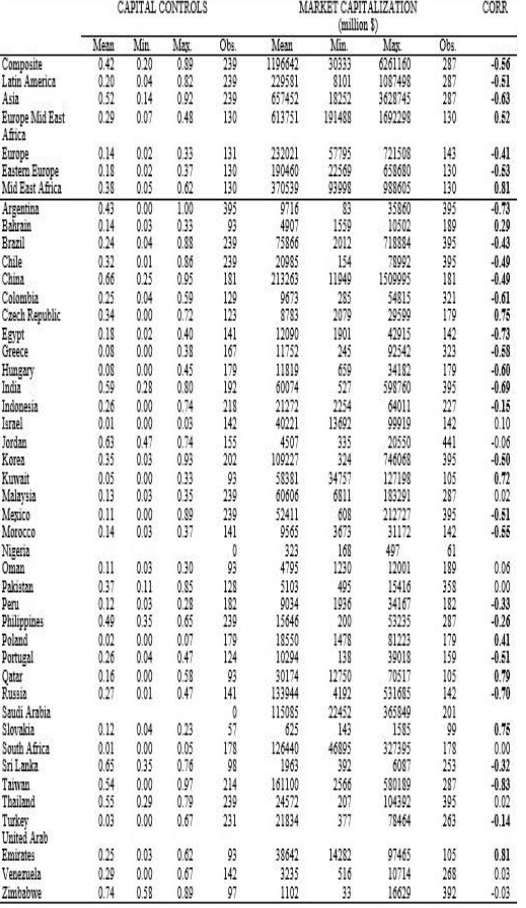
Table 2: Summary Statistics - Intensity of